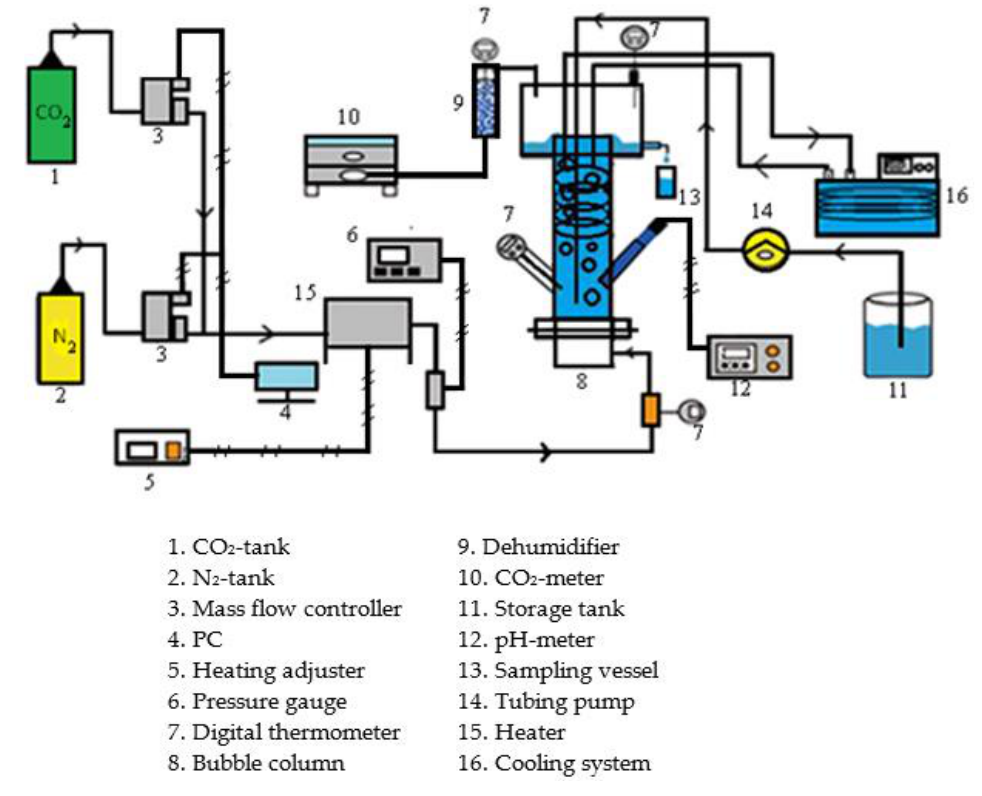
Figure 2. Experimental device for the absorption of CO 2 .